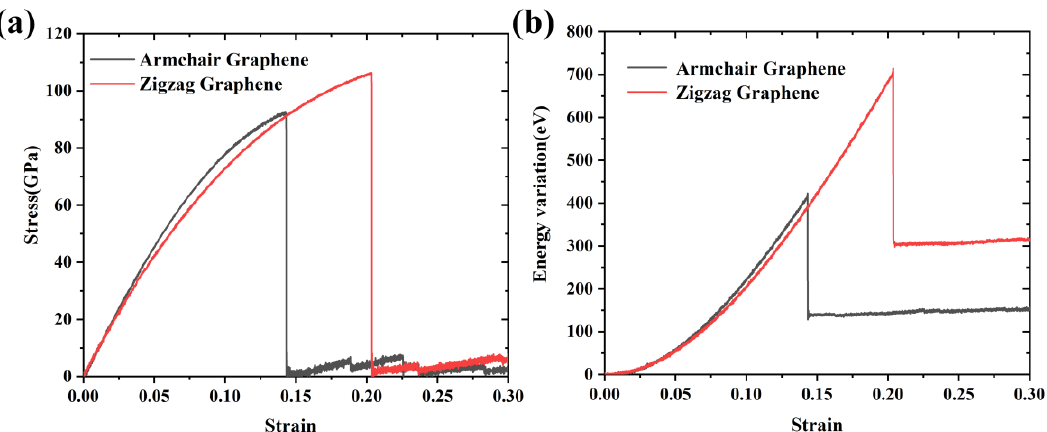
Figure 3. ( a ) Stress–strain curves for Gr along the armchair and zigzag directions; and ( b ) the total energy variations during the loading process.